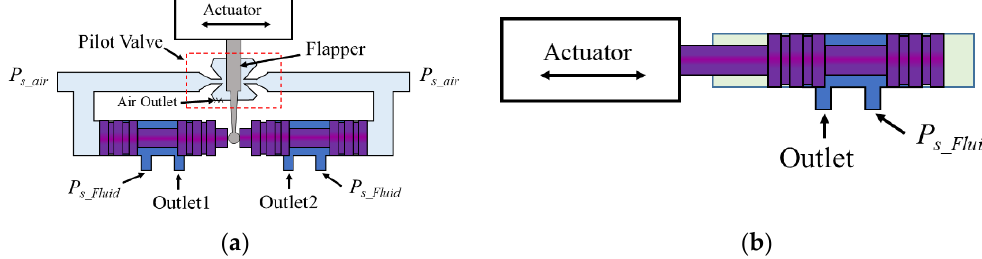
Figure 1. Schematic configuration of a valve system. ( a ) Basic working principle of two-stage valve, ( b ) Basic working principle of Single-stage valve.